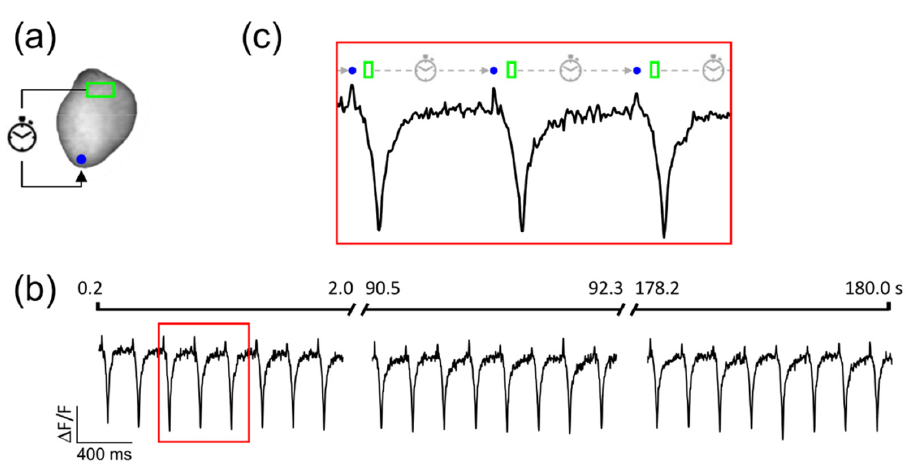
Figure 4. Stability of simulated ventricular tachycardia. ( a ) Fluorescent image of the heart. After